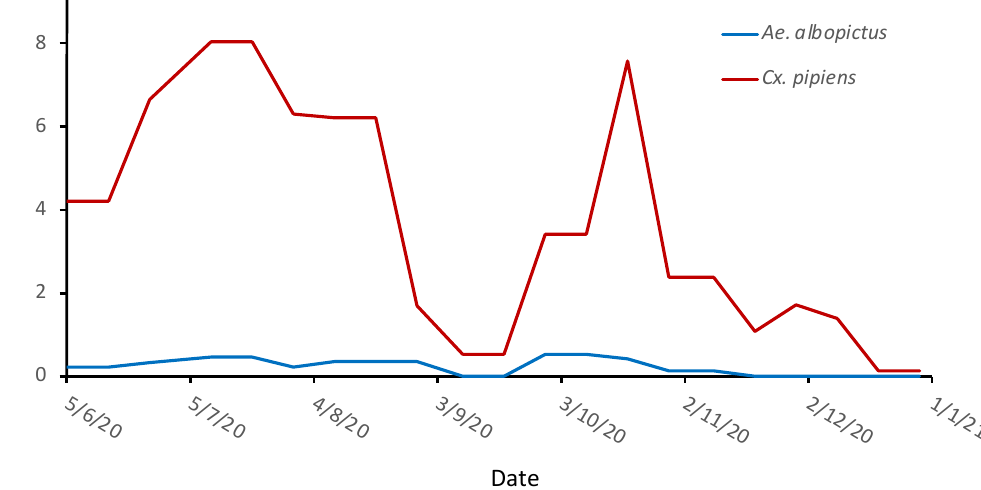
Figure 3. Number of females of Cx. pipiens s.l. and Ae. albopictus adults per day captured in the Malakasa migration camp per trap.